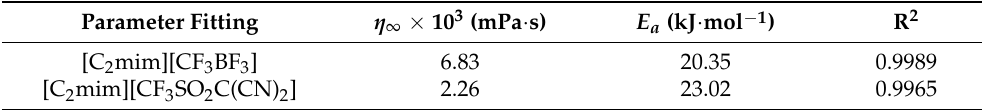
Table 2. Fitted parameters of Equation (4) for the viscosity of [C 2 mim][CF 3 BF 3 ] and [C 2 mim][CF 3 SO 2 C(CN) 2 ] with temperature.